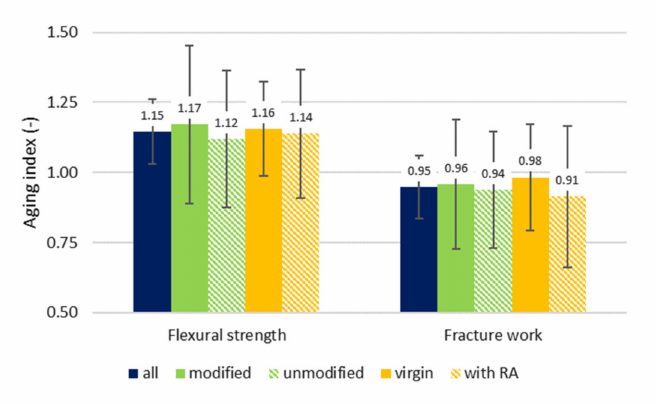
Figure 3. Average aging index—three-point bending test.